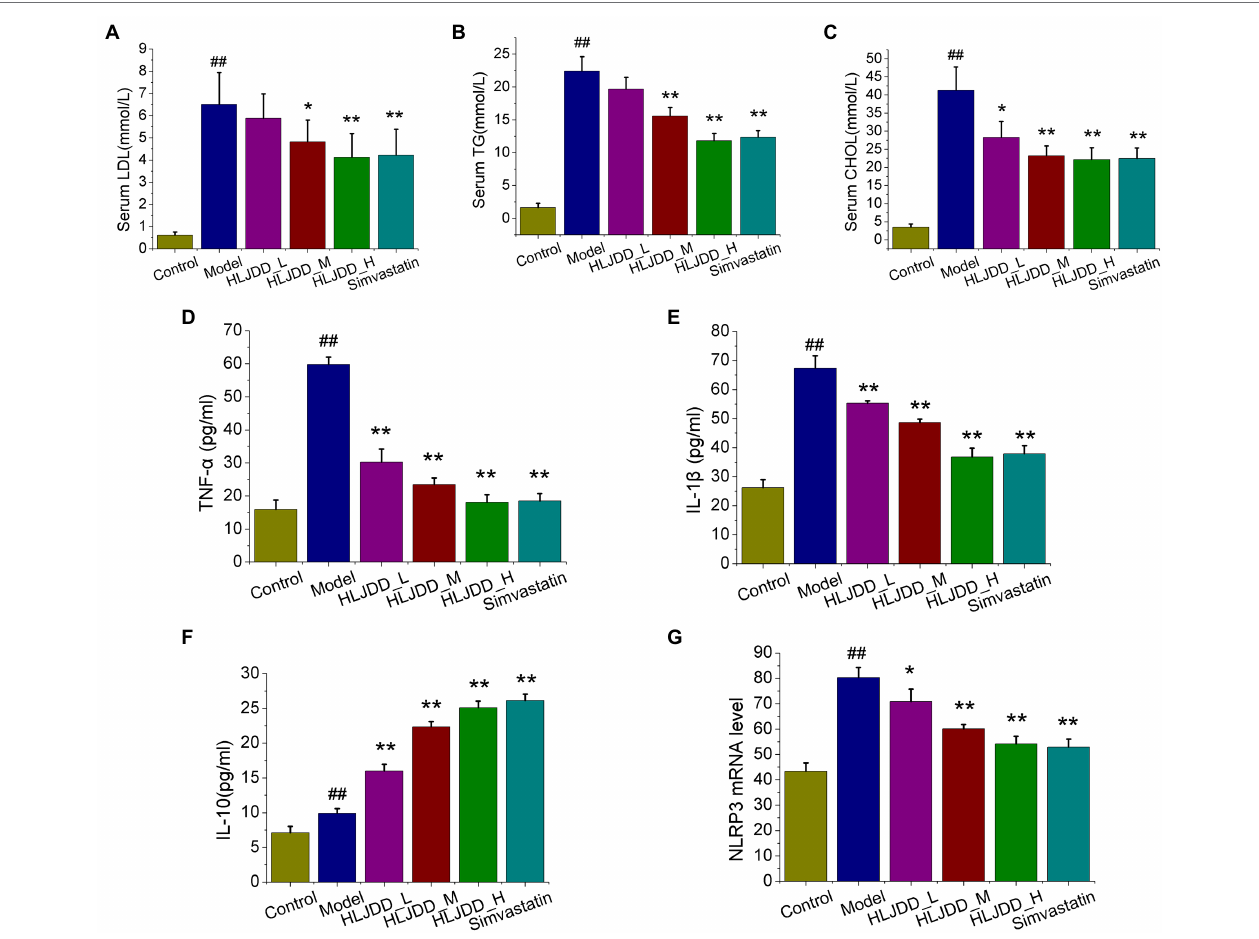
FIGURE 2 | Effects of HLJDD on serum lipid profiles and inflammatory cytokines in ApoE − / − mice with AS. The effects of HLJDD on low density lipoproteins (LDL) levels (A) , triglyceride (TG) levels (B) , and total cholesterol (CHOL) levels (C) of serum samples are shown. The effects of HLJDD on serum levels of tumor necrosis factor α (TNF- α ; D ), IL-1 β (E) , and IL-10 (F) by ELISA are shown. The effect of HLJDD on NLRP3 mRNA expression (G) in carotid tissues is shown. Values are expressed as the mean ± SD ( n = 5; ## p < 0.01 vs. the control group; * p < 0.05 and ** p < 0.01 vs. the model group; one-way